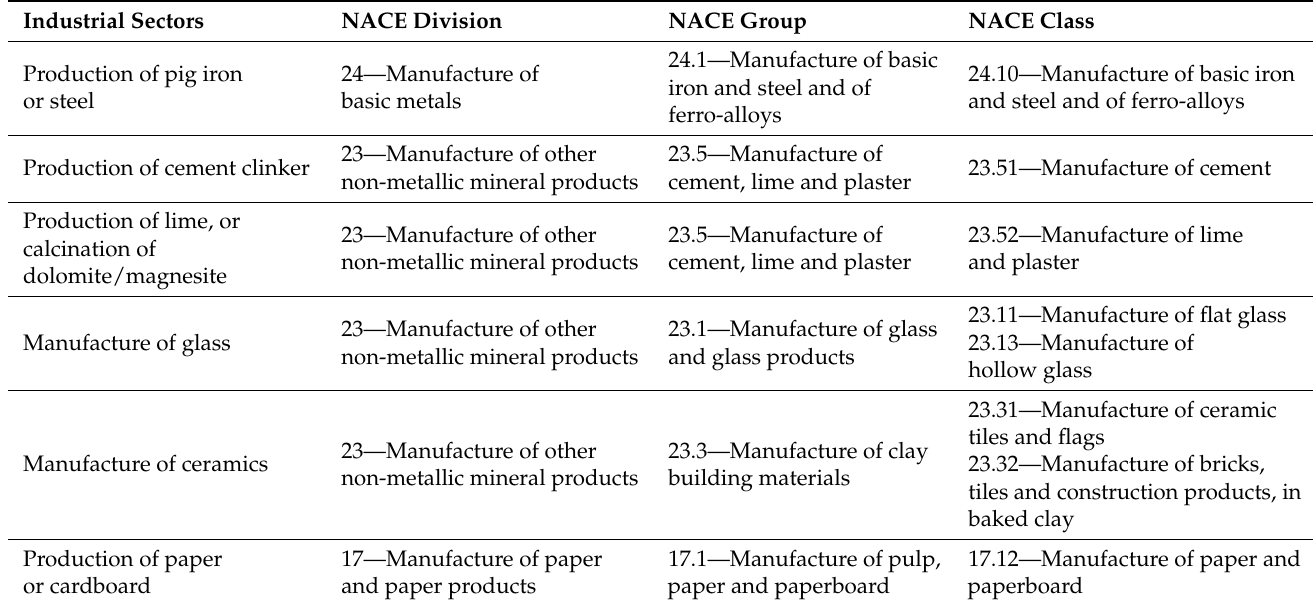
Table 2. NACE Classification of selected industrial